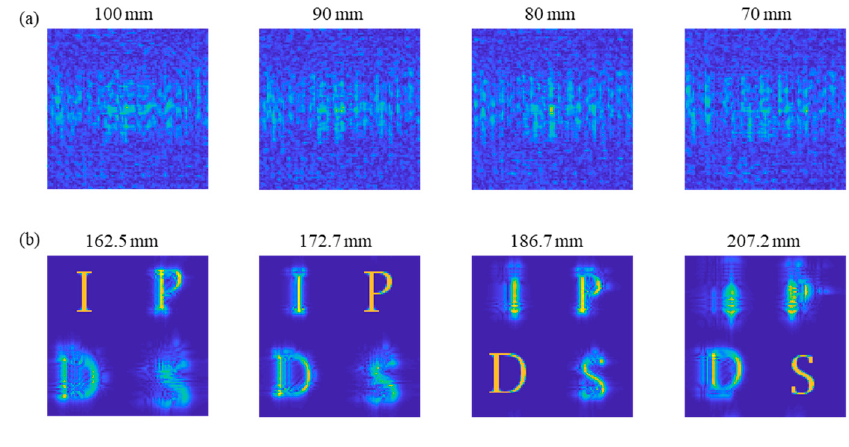
Figure 7. Back-propagated field distribution of the hologram ( a ) for the depth information (100 mm, 90 mm, 80 mm, and 70 mm) without distortion compensation, and ( b ) with distortion compensation (162.5 mm, 172.7 mm, 186.7 mm, and 207.2 mm) (Each column from the left presents the result of object ‘I’, ‘P’, ‘D’, and ‘S’).